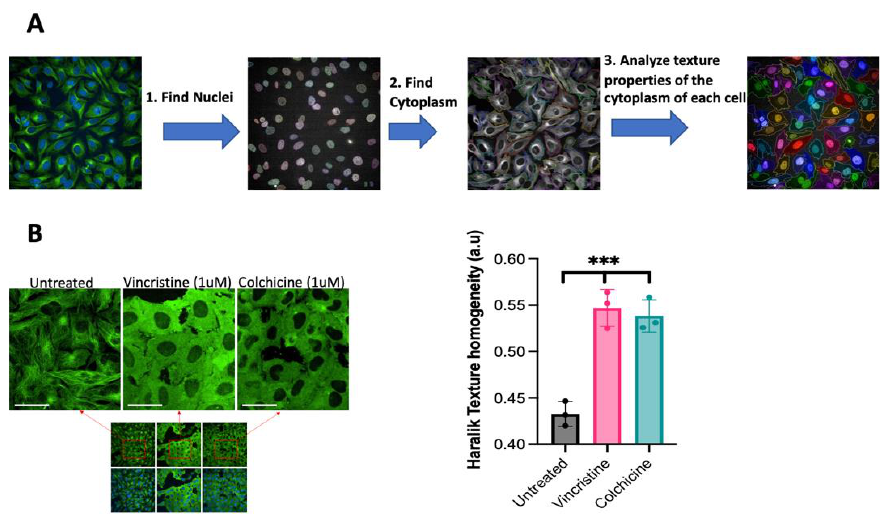
Figure 1. Detection of tubulin polymerization changes in live cells with HCI analysis. ( A ) The changes in tubulin polymerization were detected and quantified in each microscopic image with the following image analysis workflow: first, detection of the nuclei of every cell in the image using the blue fluorescent channel for detecting histone H1-mTagBFP2. Second, detection of the cytoplasm of every nuclei that was identified in the first step using the green fluorescent channel for detecting β -tubulin-mClover3. Third, quantitate the image texture properties of the cytoplasm of every cell. ( B ) Confocal microscopy images of live CRISPR-edited HeLa cells with fluorescent tagging of histone H1 and β -tubulin. The tubulin polymerization inhibition was detected after treatment with known tubulin polymerization inhibitors (vincristine and colchicine). The changes in tubulin polymerization with each treatment were quantified with the Haralick texture homogeneity algorithm and are shown on the right panel. Differences were analyzed by one-way analysis of variance (ANOVA), and p < 0.05 was considered statistically significant. *** p < 0.001; error bars represent ± standard deviation ( SD ) of images from triplicate wells. These data are representative of three independent experiments; scale bar = 15 μm.